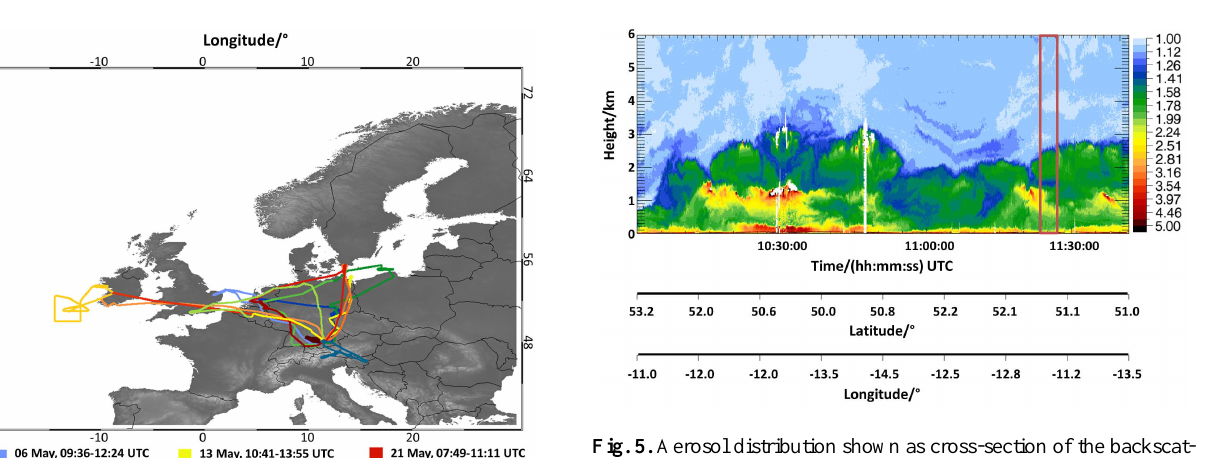
Fig. 5. Aerosol distribution shown as cross-section of the backscat- ter ratio at 532nm along the flight track on 14 May 2008 shown in Fig.